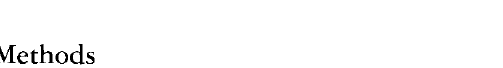
Fig. 1. Boundaries of Davis reindeer range on rhe Seward Peninsula,